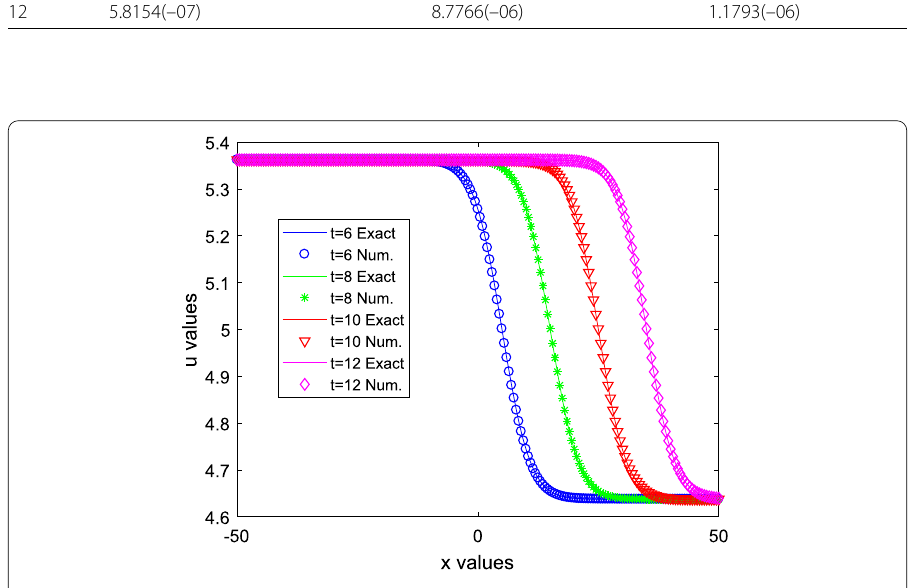
Figure 2 Example 2: Comparison between numerical and exact solutions at different time levels